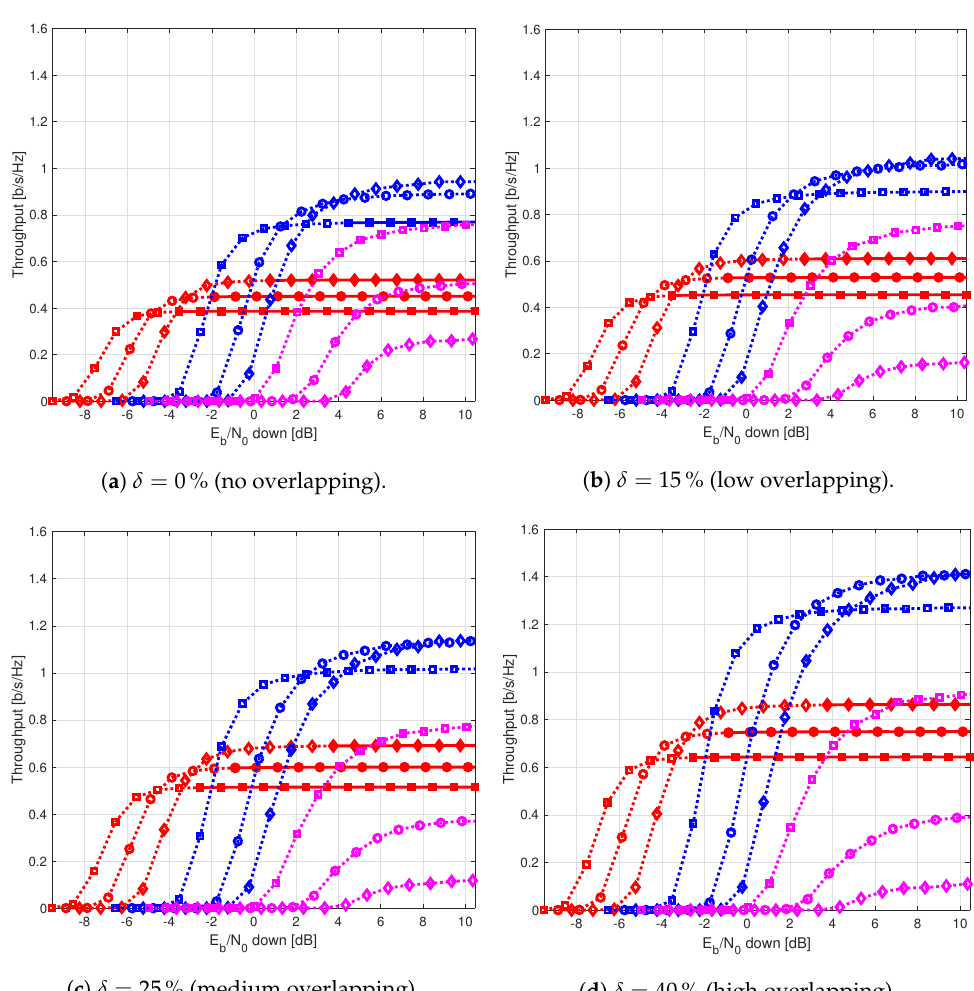
Figure 11. End-to-end throughput versus E b / N 0 in the access link for a NB-IoT frame (SNR fl = 15dB). NB-IoT code rates: 0.2222 (red square), 0.259 (red circle), 0.3 (red diamond), 0.444 (blue square), 0.5319 (blue circle), 0.6 (blue diamond), 0.6386 (magenta square), 0.7678 (magenta circle), 0.8628 (magenta diamond). Solid (dashed-) lines with (un)filled markers: BLER ≤ 10 − 2 requirement (not)fulfilled. Wind speed: v = 21 m/s. Diameter of telescope aperture: W 0 = 10cm. Figure 12 shows the throughput for each code rate and overlapping factor for Case 2 (Decode-and-forward with NB-IoT). From this figure, it is possible to observe that the regeneration of the NB-IoT signal in the satellite permits to use also medium code rates (i.e., R c ,iot = 0.4444) with overlapping factor δ = 0 and 15%. Therefore, it means that the largest throughput is not obtained with the largest possible overlapping factor (i.e., δ = 40%) and low code rates (i.e., R c ,iot = 0.3) as in the previous case, but with a low-to-moderate overlapping factor (i.e., δ = 15%) and a medium code rate (i.e., R c ,iot =